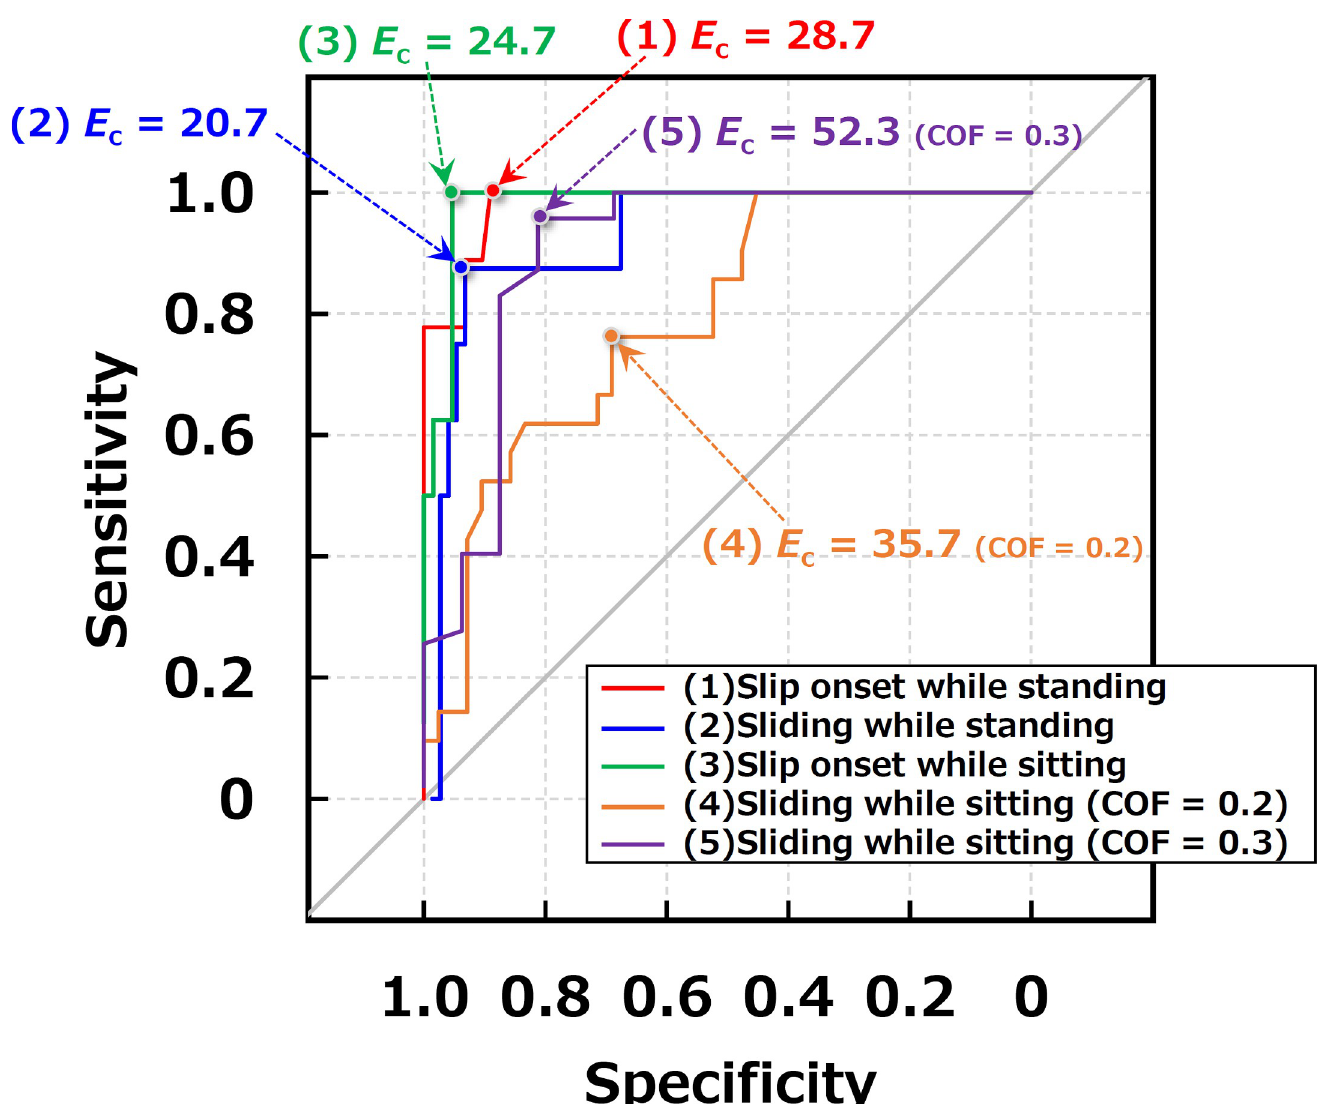
Fig 7. ROC curves for participants with the capability of perceiving friction.